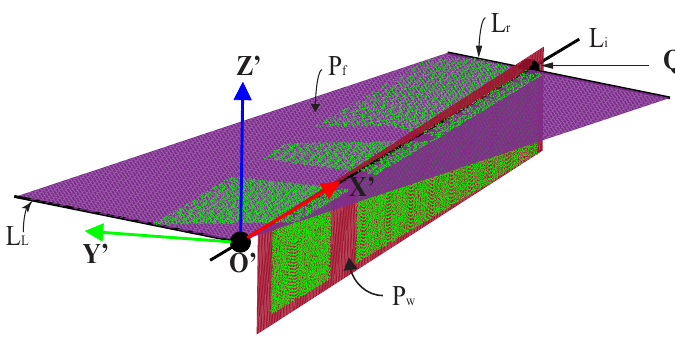
Figure 5. plane representation for web and flange